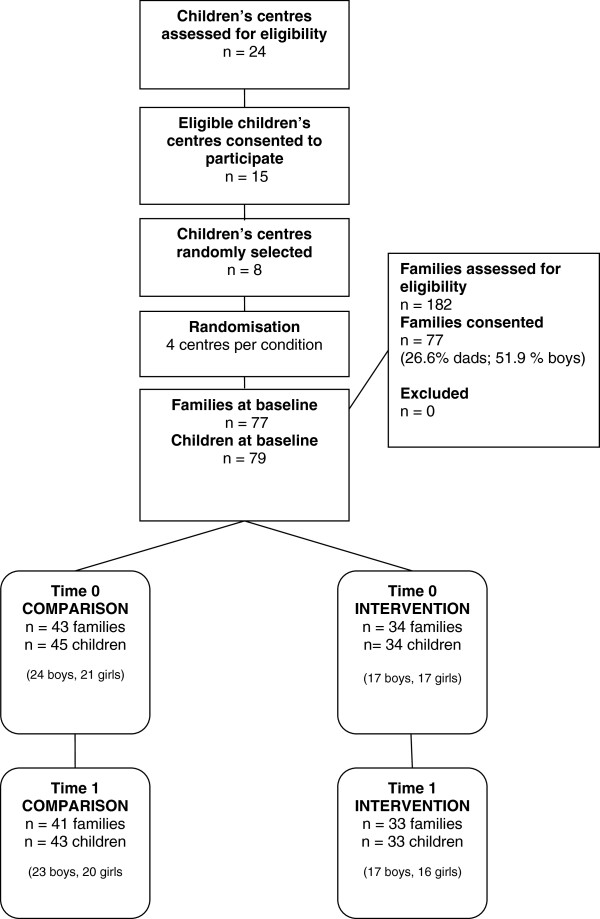
Children centre and flowof families through theproject.